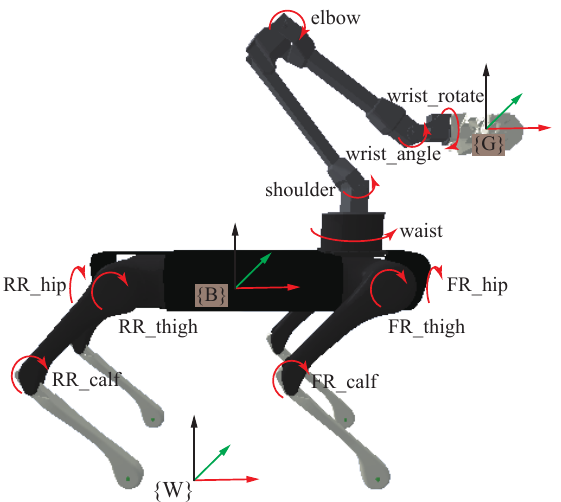
Figure 1. Configuration of Aliengo VX300. The robot consists of an Aliengo quadrupedal robot created by the Unitree and a five-DOF ViperX 300 robotic arm from Trossen Robotics. Each leg has 3 joints called hip, thigh and calf joints. The arm has only 5 joints, namely, waist, shoulder, elbow, wrist_angle and wrist_rotate